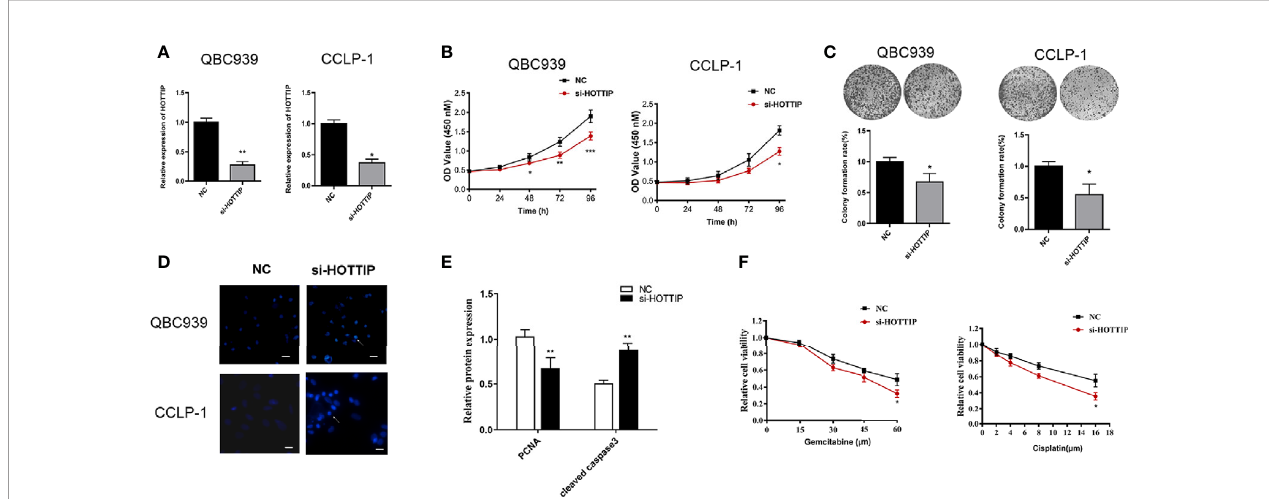
FIGURE 2 | HOTTIP inhibition increased the susceptibility to chemotherapy of CCA in vitro . (A) The relative expression of HOTTIP quanti fi ed by qRT-PCR in CCA cell lines treated with the si-HOTTIP. (B) The proliferation of QBC939 and CCLP-1 cells. The si-NC or si-HOTTIP-transfected cells were pretreated with CG for 24 h before normal incubation. (C) The impact of HOTTIP inhibition on cell colony formation. Before the colony formation assay, CG pretreatment was performed. (D) Apoptosis was detected by Hoechst staining. (E) PCNA and cleaved caspase-3 expression was measured by qRT-PCR. (F) The viability of QBC939 and